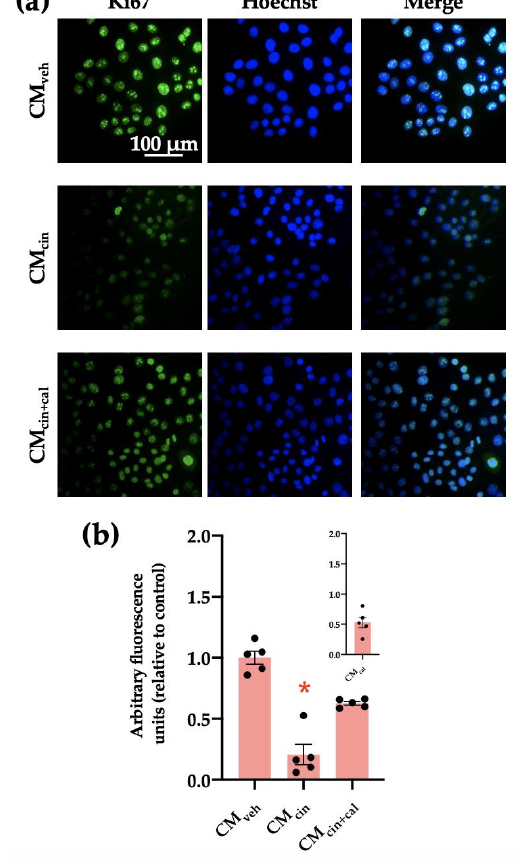
Figure 3. CaSR activation in SW872 pre-adipocytes induces the secretion of factors that induce cell cycle arrest in HepG2 cells: ( a ) representative images of HepG2 cells exposed to the CM veh , CM cin , and CM cin+cal . Hoechst (blue) was used to identify the nuclei and anti-Ki67 antibody (green) to evaluate the nuclear localization of Ki67 (scale bar = 100 µ m); ( b ) quantification of total Ki67 immunofluorescence. The inset shows CM cal immunofluorescence relative to the control. Each dot represents an individual experiment ( n = 5). * p < 0.05 versus the control, Friedman’s test, and Dunn’s post-hoc test.